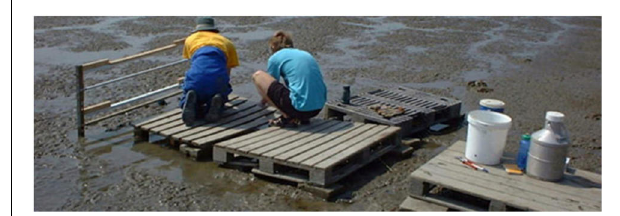
FIGURE 2 | Setup of the sampling platform showing the removable “bridge” to the 1-m transect marked by the vertical frame to the left of the image.